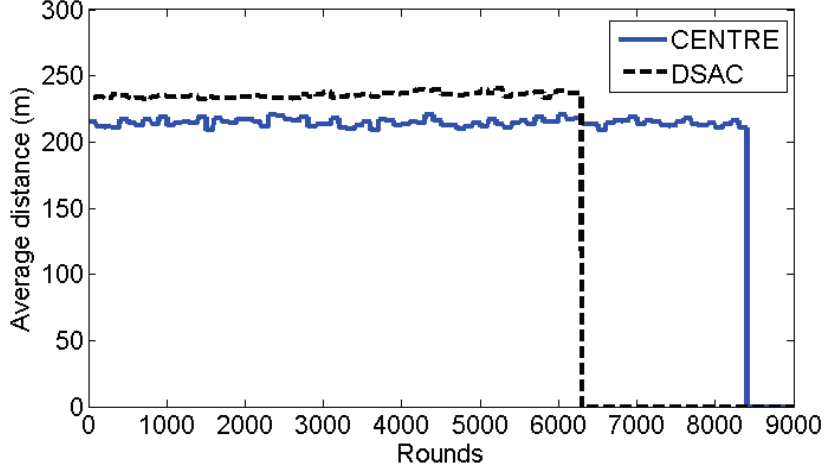
Figure 13. Average distance between the cluster heads and their cluster members (showed until the lifetime of the two